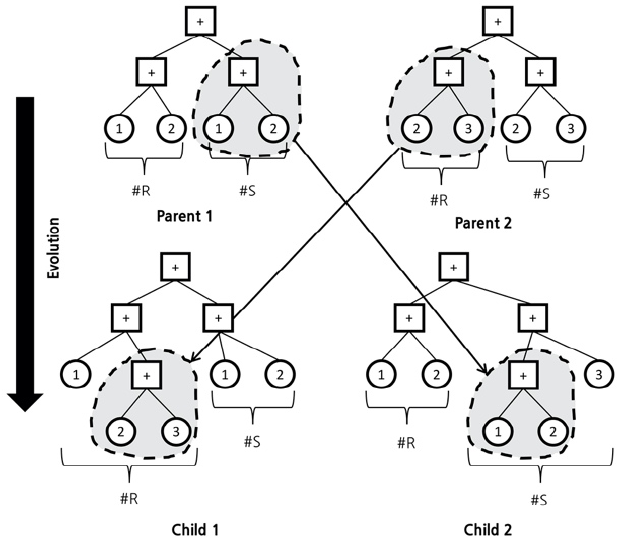
Figure 7. Concept of the crossover method in GP.